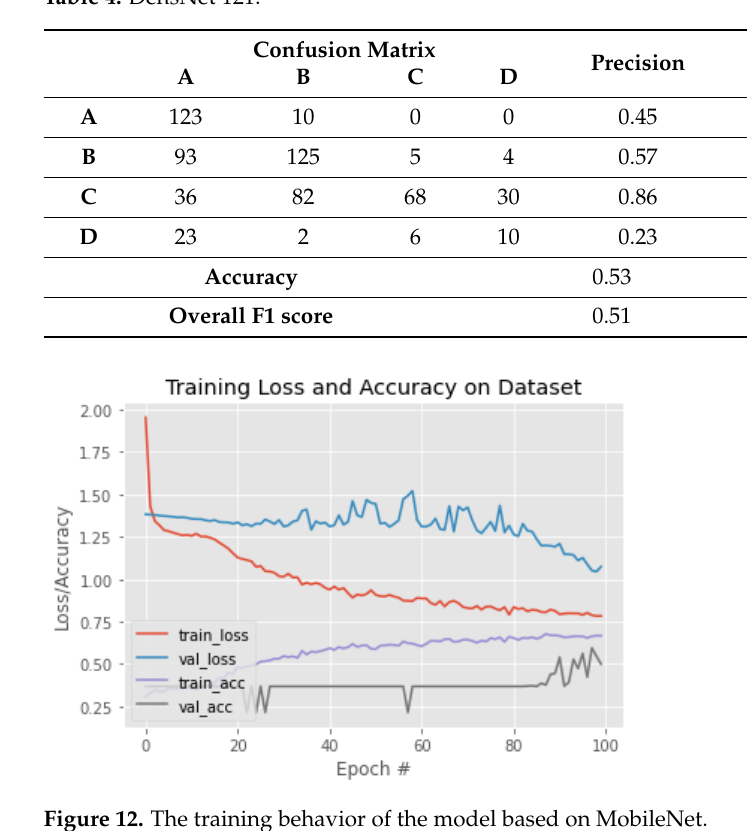
Figure 11. The training behavior of the model based on DenseNet121. Table 4. DensNet 121.